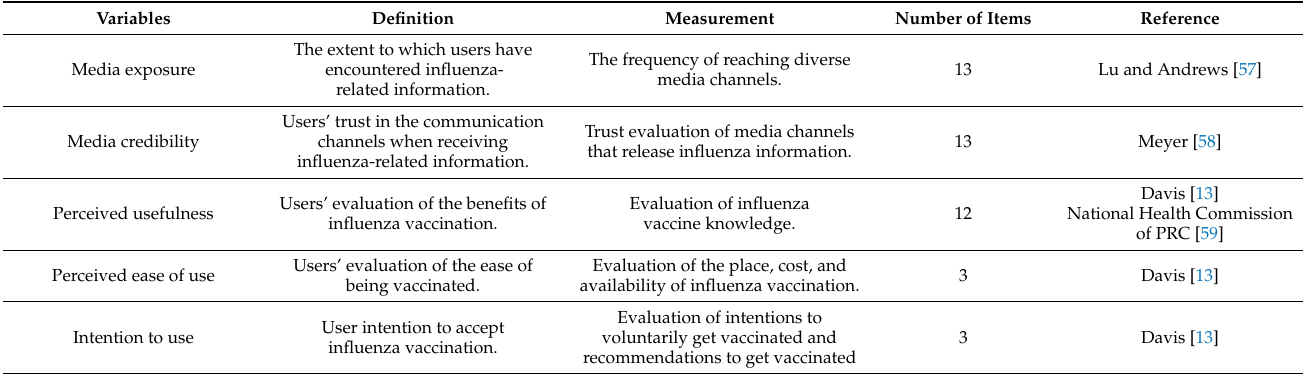
Table 1. Definition of variables, measurement, and references.